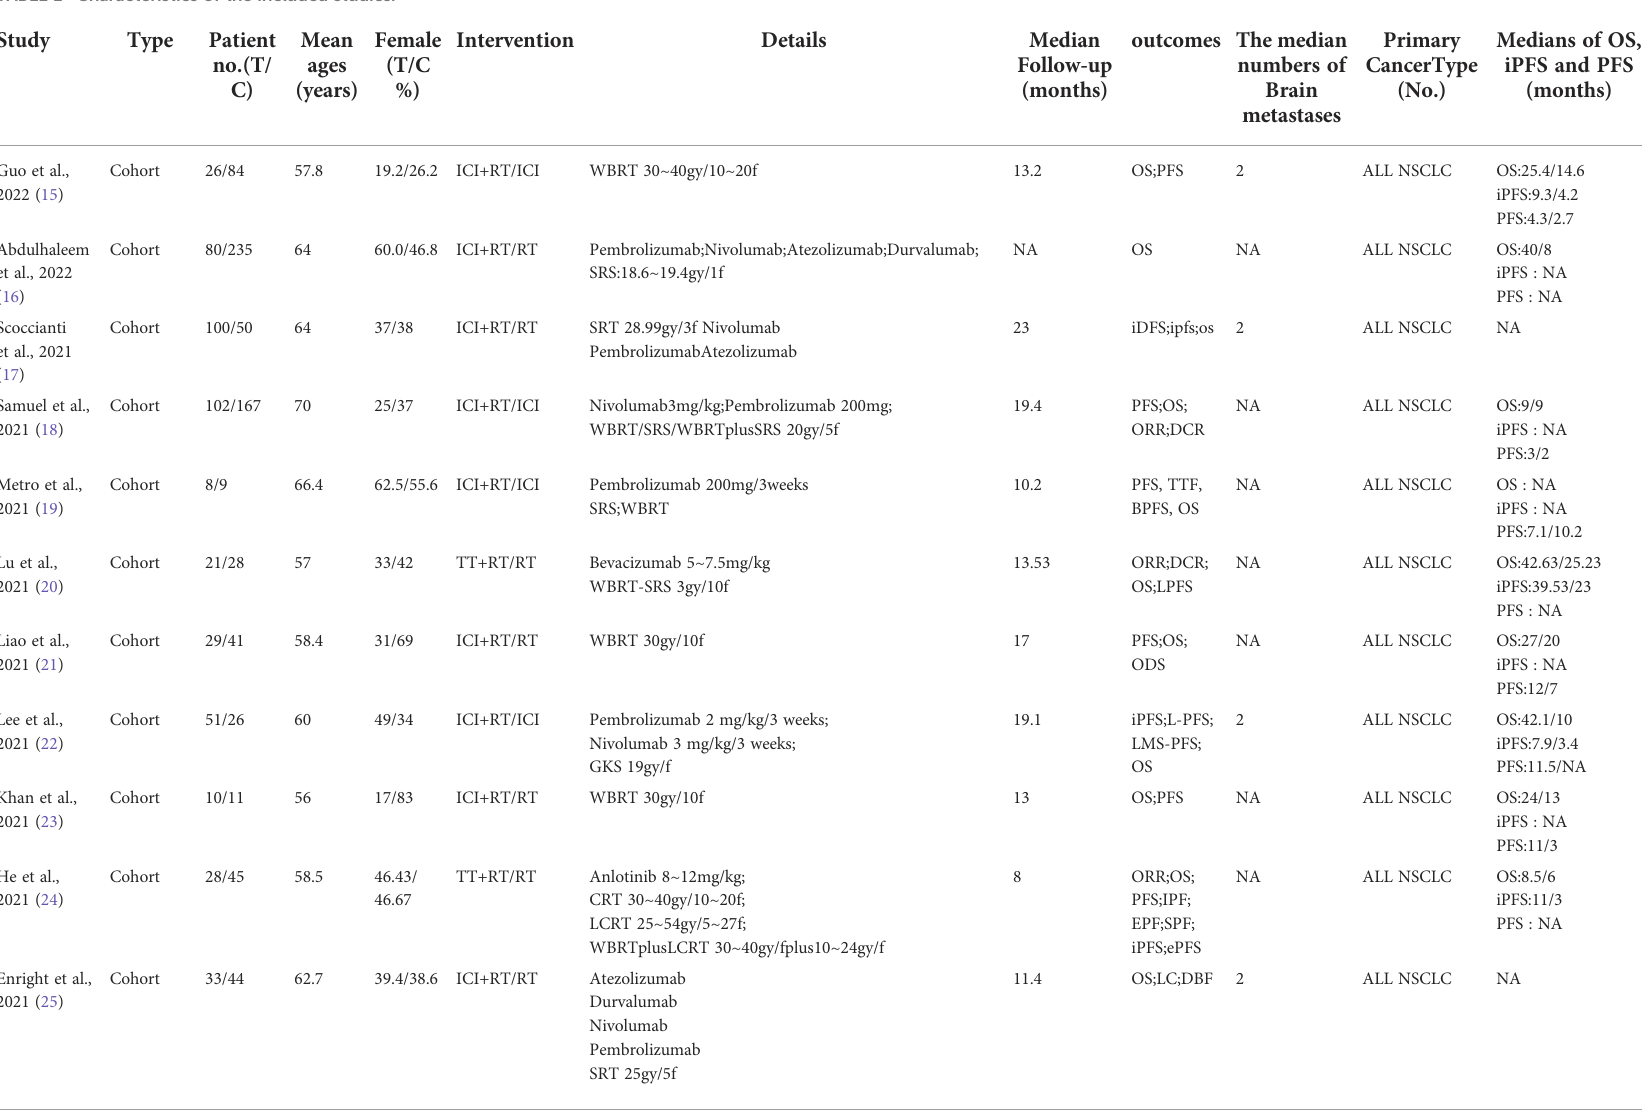
TABLE 1 Characteristics of the included